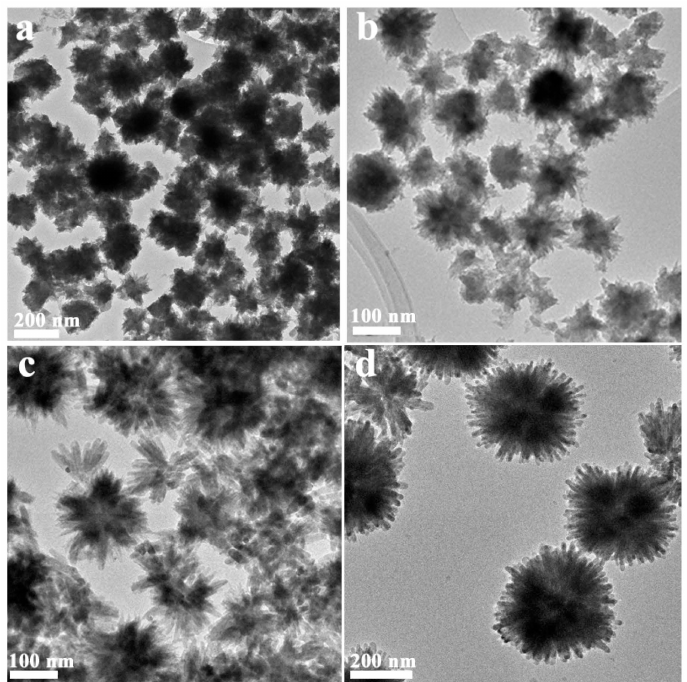
Figure 3. TEM images of the MoS 2 QDs/CdS samples prepared for different times: ( a ) 5 min; ( b ) 15 min; ( c ) 30 min; ( d ) 60 min.